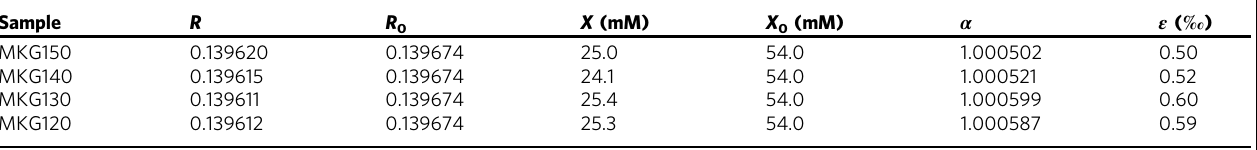
Table 5 Rayleigh fractionation calculation parameters